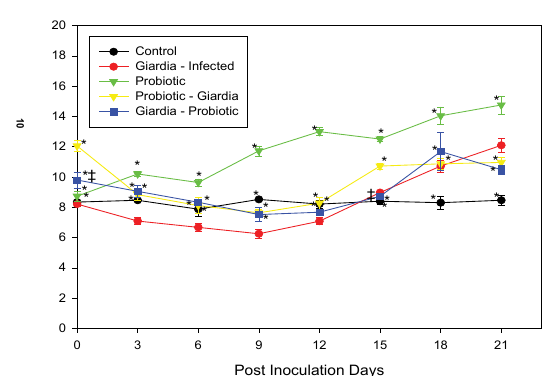
Figure 2. Lactobacilli count in faeces of mice belonging to different groups using L. acidophilus as the probiotic. Values